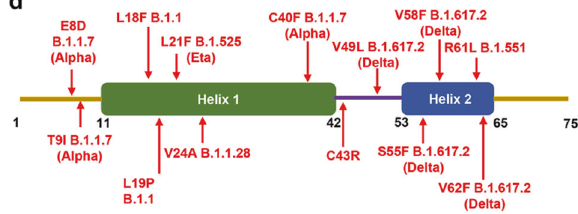
Fig. 6d A schematic of E showing the positions of variations found in SARS-CoV-2 variants. (7) The plus signs and minus signs in Fig. 6e should line up with the lane.